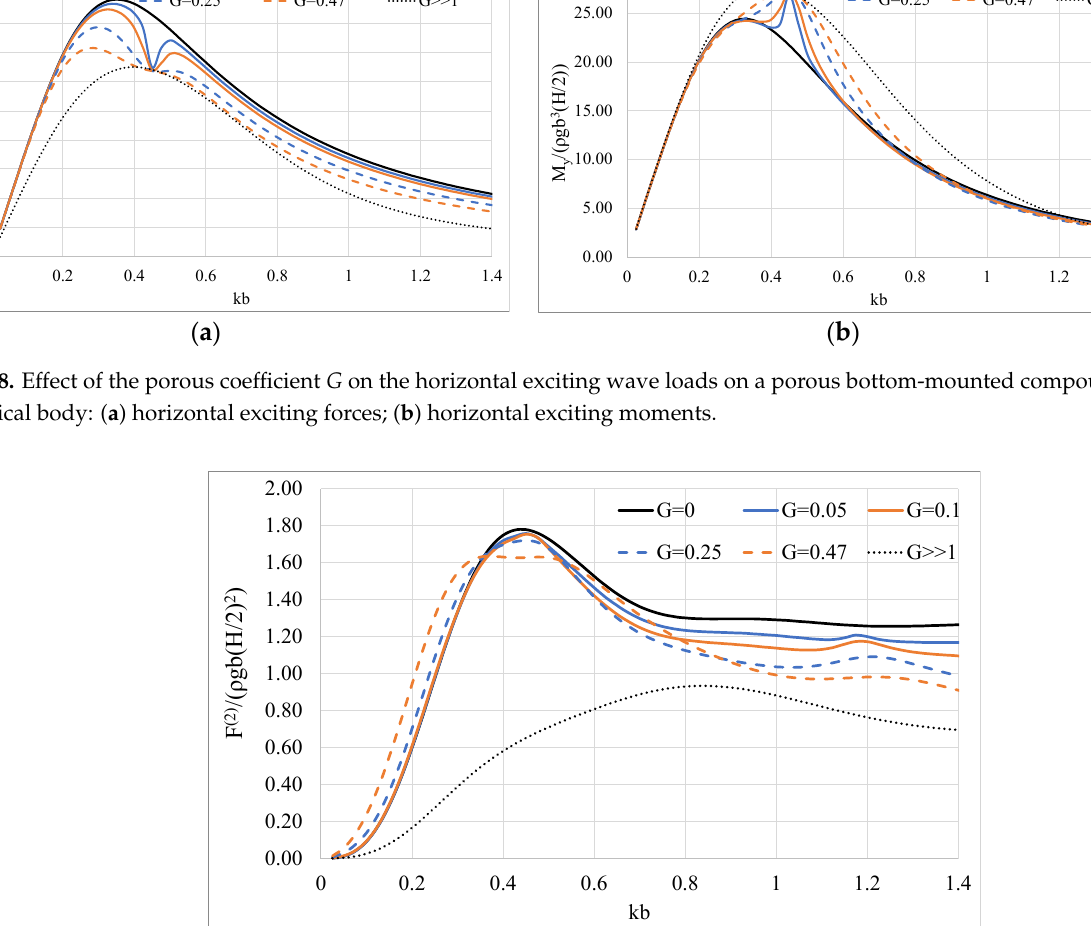
Figure 9. Effect of the porous coefficient 𝐺 on the mean drift forces on a porous bottom-mounted compound cylindrical body.